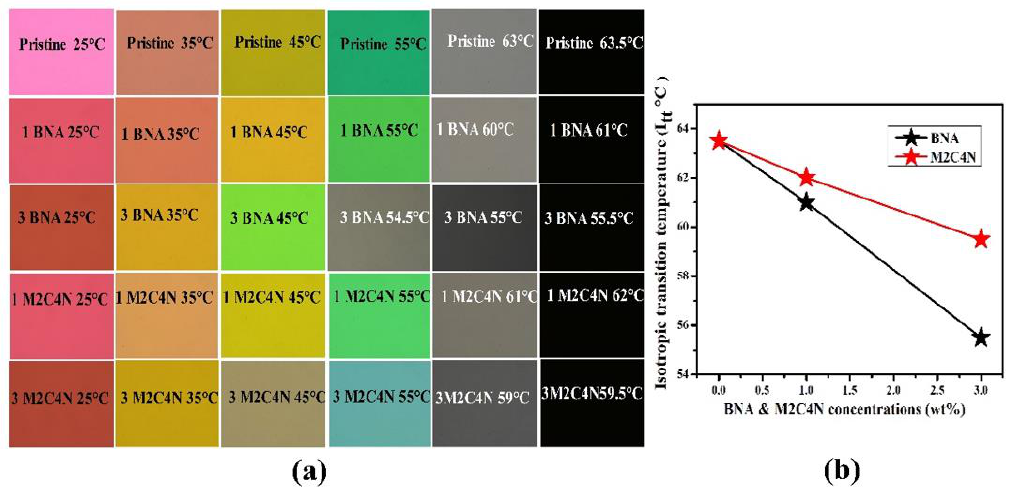
Figure 3. ( a ) Polarizing optical microscope (POM) photographs and ( b ) T NI of the BNA-LC and M2C4N-LC